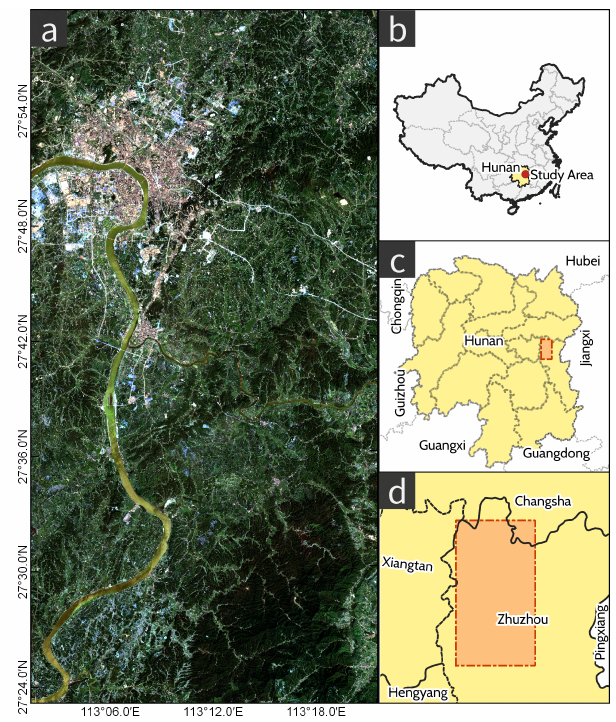
Figure 1. Map of the study area ( a ): Raw Sentinel 2 scene on Sep 15, 2017. ( b ): Study area in relation to China. ( c ): Study area in relation to Hunan Province, China. ( d ): Study area and surrounding